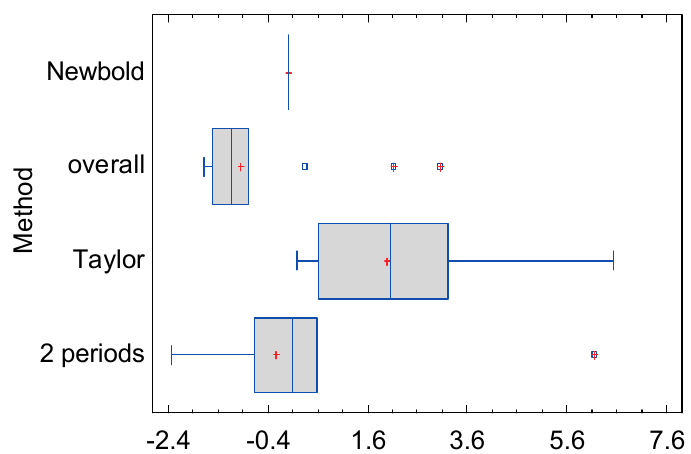
Figure 4. Distribution of initial values obtained for the trend in additive trend models AMC 24,168 and AAC 24,168 .